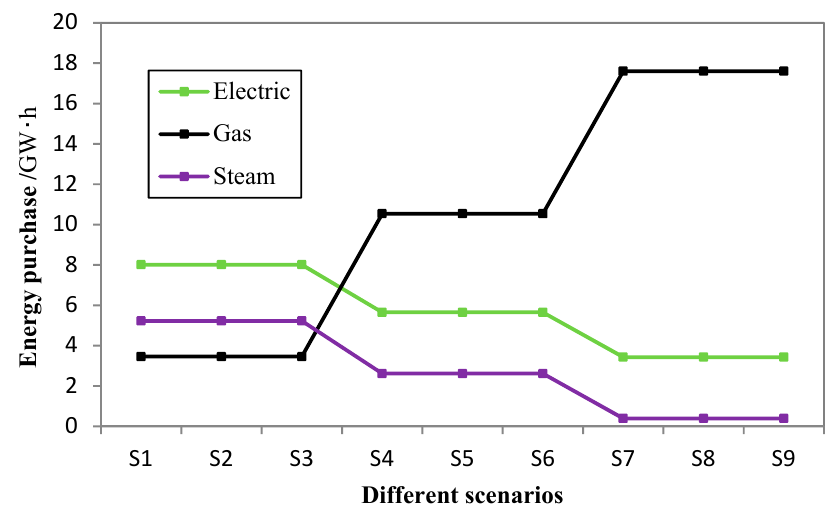
Figure 6. Stage 2 energy purchase situation under different scenarios.